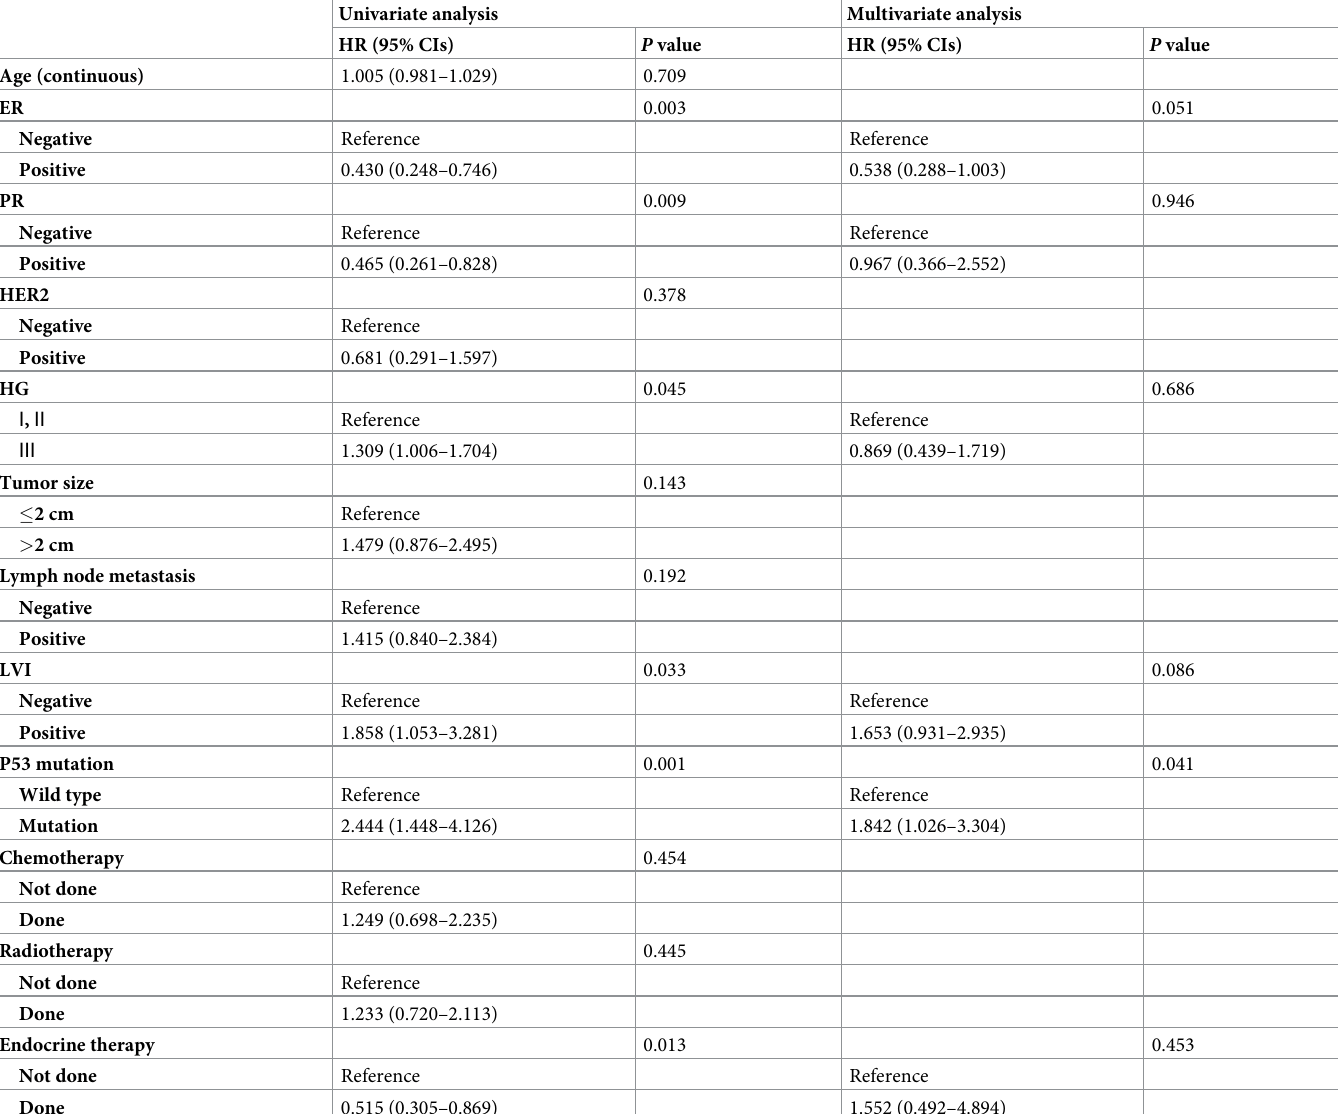
Table 3. Uni- and multivariate analysis for recurrence-free survival in patients with low nuclear YAP1 expression tumors. Univariate analysis Multivariate